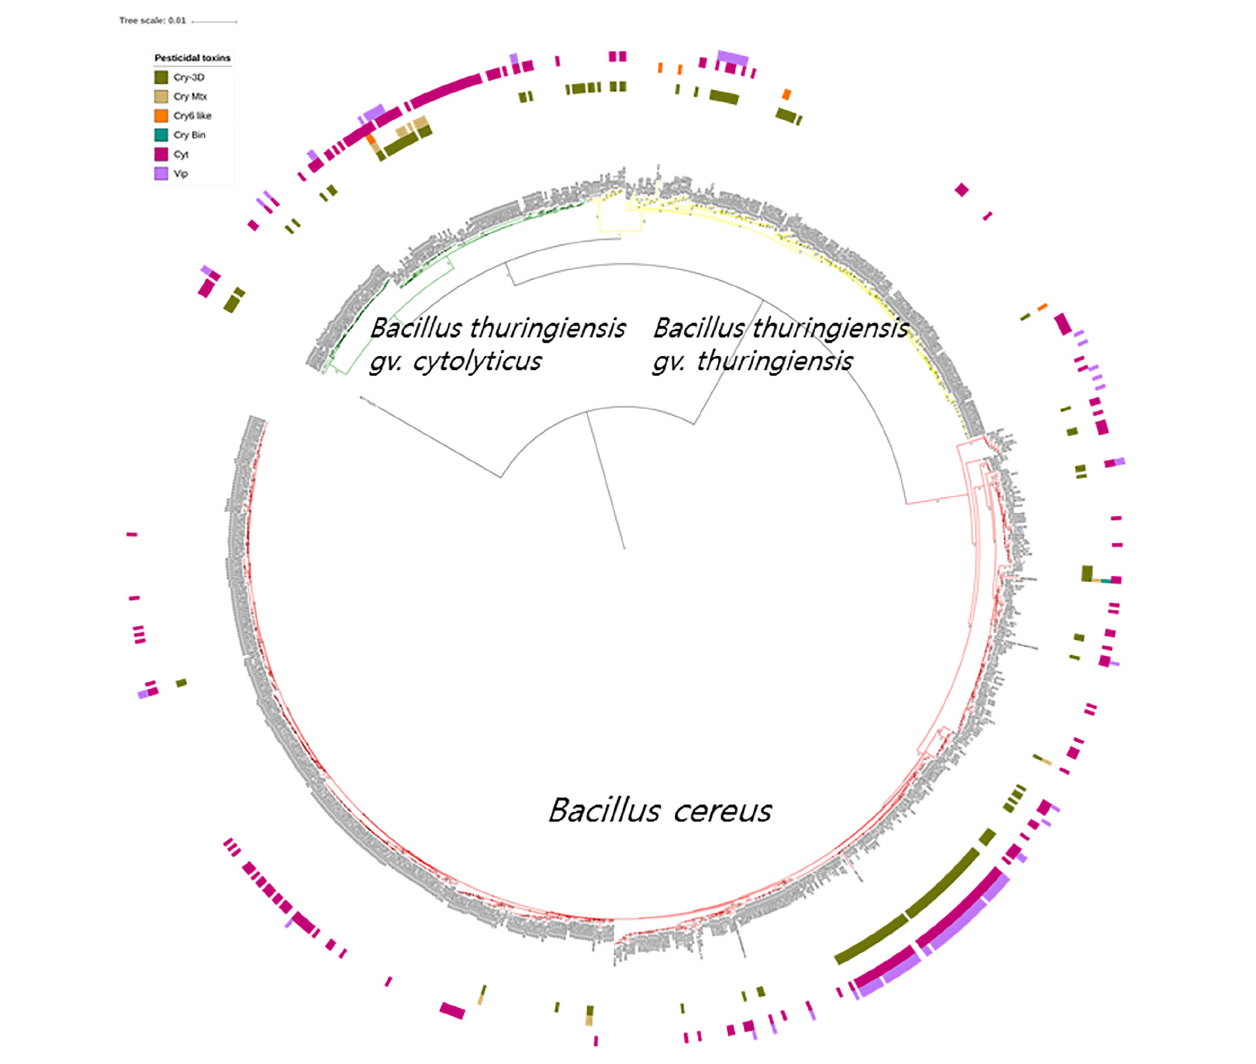
FIGURE 4 | The bacterial core gene-based phylogenomic tree of Bacillus cereus and Bacillus thuringiensis strains together with labeled pesticidal genes. The numbers at each branching points are bootstrap values. Bar indicates the nucleotide substitution rate per site. Bacillus toyonensis BCT-7112 T was used as the outgroup. Taxonomic groups are indicated in different colors: red, B. cereus ; yellow, B. thuringiensis gv. thuringiensis ; and green, B. thuringiensis gv. cytolyticus . Genes are displayed on the outer circles: Cry 3D, insecticidal crystal protein with three protein domains; Cry Mtx, insecticidal crystal protein that